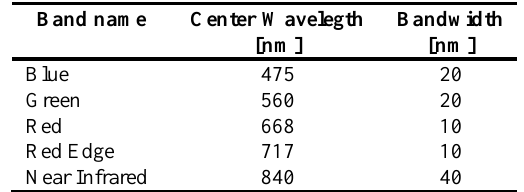
Table 1. Band specifications of the MicaSense RedEdge-M camera. Table 3. Descriptive statistics of dry biomass yield for each